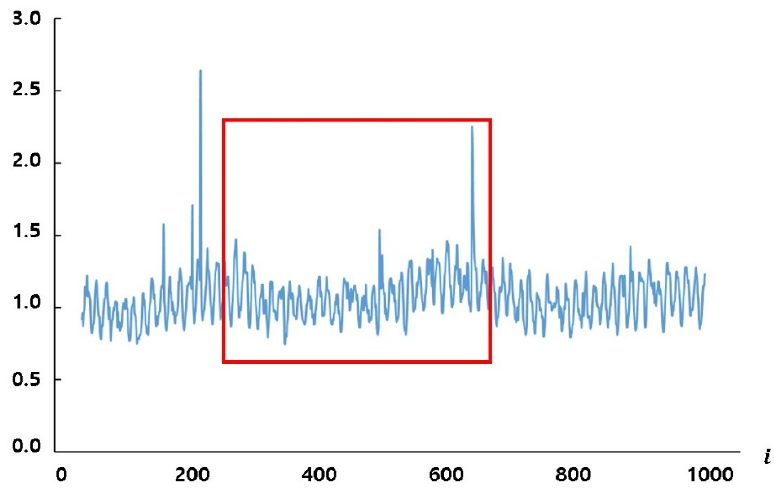
Figure 12. Water level time series in tidal river used for CRP.